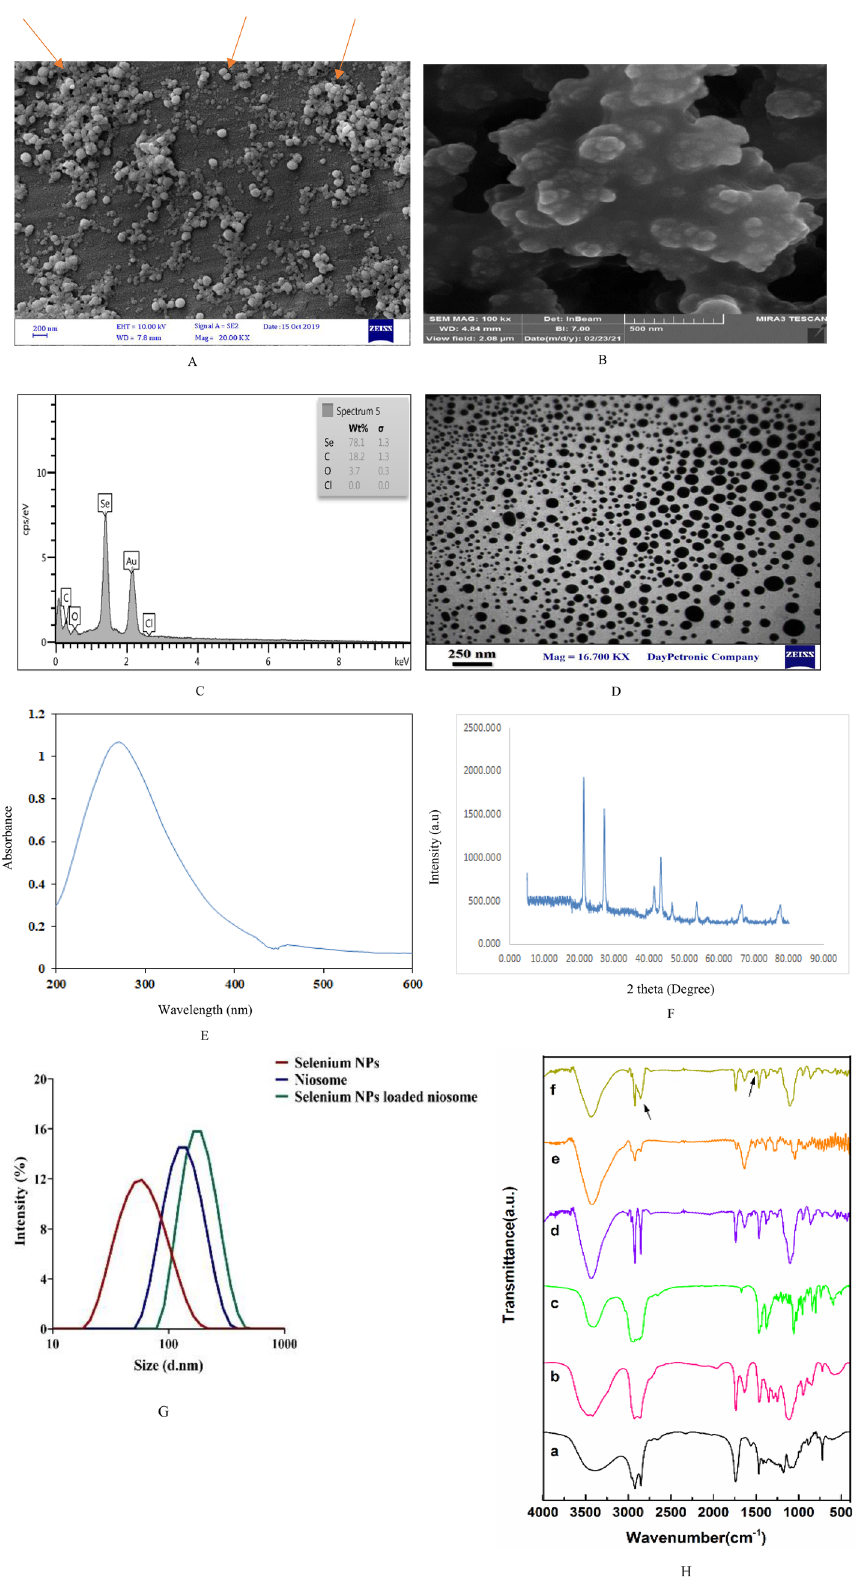
Figure 1. The synthesized SeNPs and niosome-loaded SeNPs characteristics. ( A ) SEMof green synthesized SeNPs, ( B ) SEM of noisome loaded SeNPs, ( C ) EDX analysis of synthesized SeNPs, ( D ) TEM of SeNPs, ( E ) UV– vis spectra of biosynthesized SeNPs, ( F ) XRD analysis of SeNPs, ( G ) DLS analysis of niosome loaded SeNPs, ( H ) FT-IR spectra of Tween 60 (a), Span 60 (b), Cholesterol (c), Niosome (d) and SeNPs (e) and Niosome-loaded SeNPs